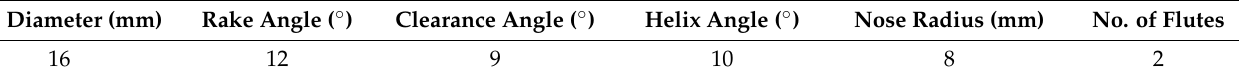
Table 3. The geometry of the cutting tool.